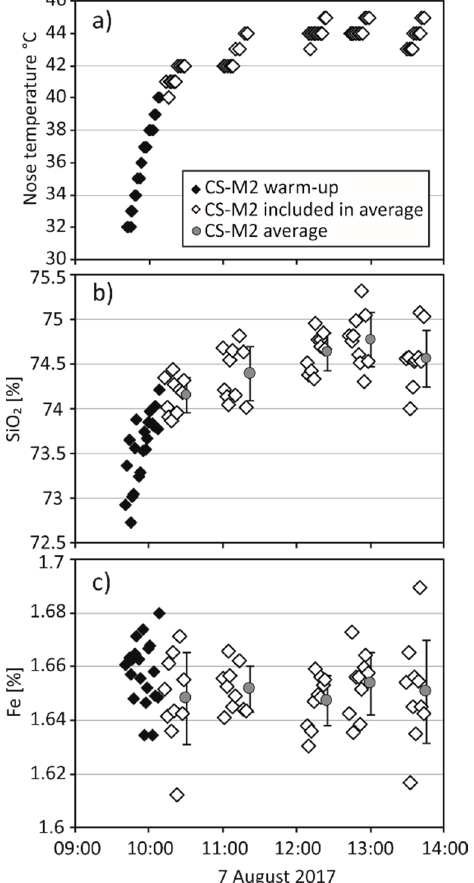
Figure 1. Data collected for the CS-M2 sample supplied by Bruker during one measurement session (7 August 2017). ( a ) Nose temperature (°C) versus the time of the measurement. ( b , c ) Element concentrations (SiO 2 and Fe in %) of individual CS-M2 measurements versus the time of the measurement. Additionally shown are averages of 10 consecutive CS-M2 measurements ± one standard deviation (SD).